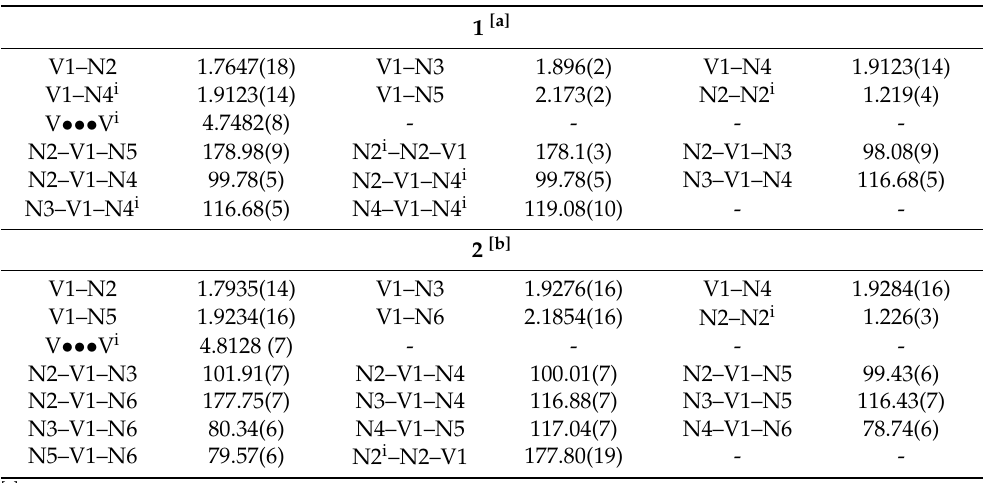
Figure 2. X-ray structures of 1 ( left ) and 2 ( right ) with the atom numbering scheme (50% probability thermal ellipsoids). Hydrogen atoms except for the hydrogen on the methine carbons and disordered atoms are omitted for clarity. The atoms with superscripts i, ii, and iii in structure of 1 are related to the atoms without them by symmetry operations (x, 1 − y, 1 − z), (1 − x, 1 − y, 1 − z), and (x, 1 − y, − z), respectively. The atoms with and without superscript i in the structure of 2 are related to each other by symmetry operation (1/2 − x, 3/2 − y, 1 − z). Table 1. Selected bond lengths (Å) and angles (deg) for 1 and 2